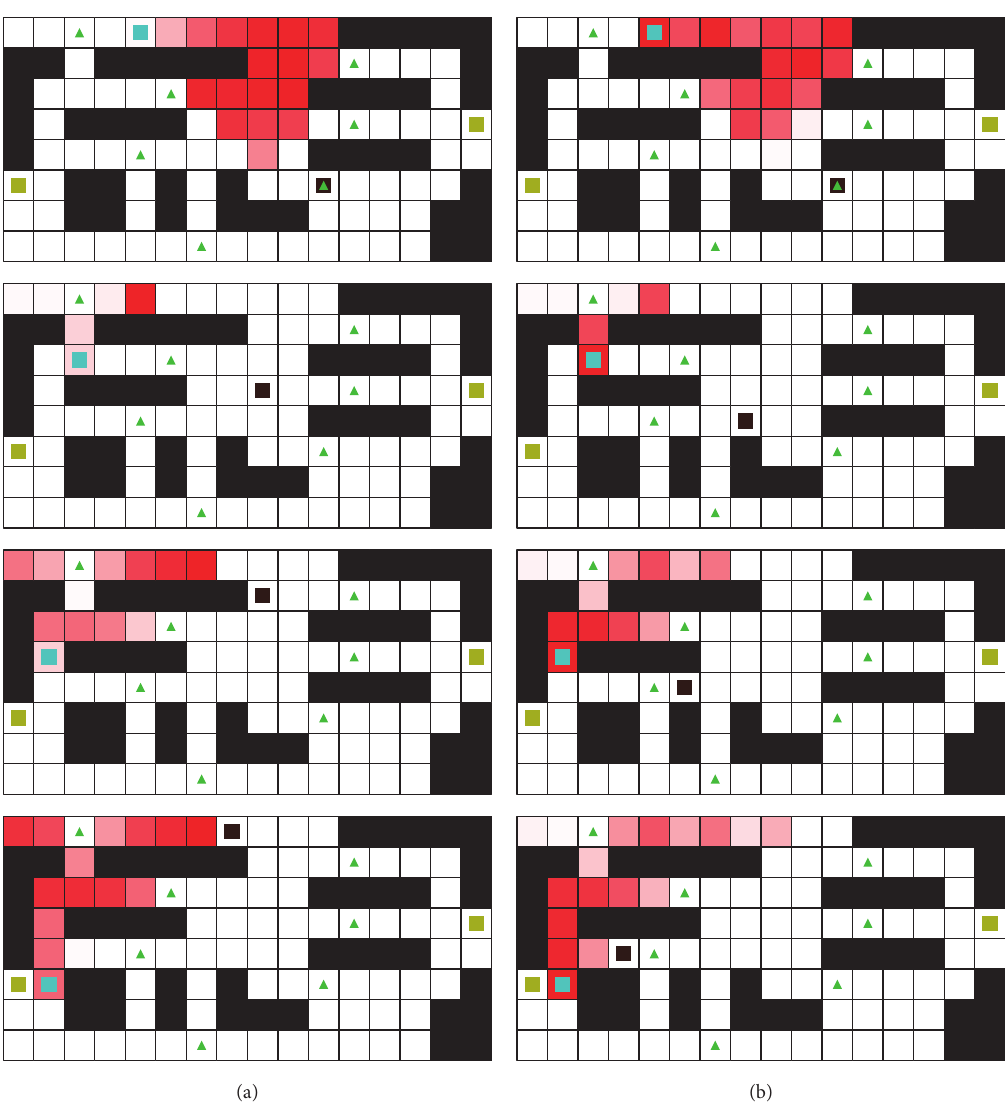
Figure6:Thesegraphicsrepresentthe6th,10th,12th,and14thturnoftwogames.(a)isthefirstgameagainstanewplayer,while(b)represents the eleventh game against the same player. The turquoise square represents the human player, the intelligence’s avatar is the dark brown square, the green triangles represent the parrots, and objectives are represented by the golden squares. The player alternated between two